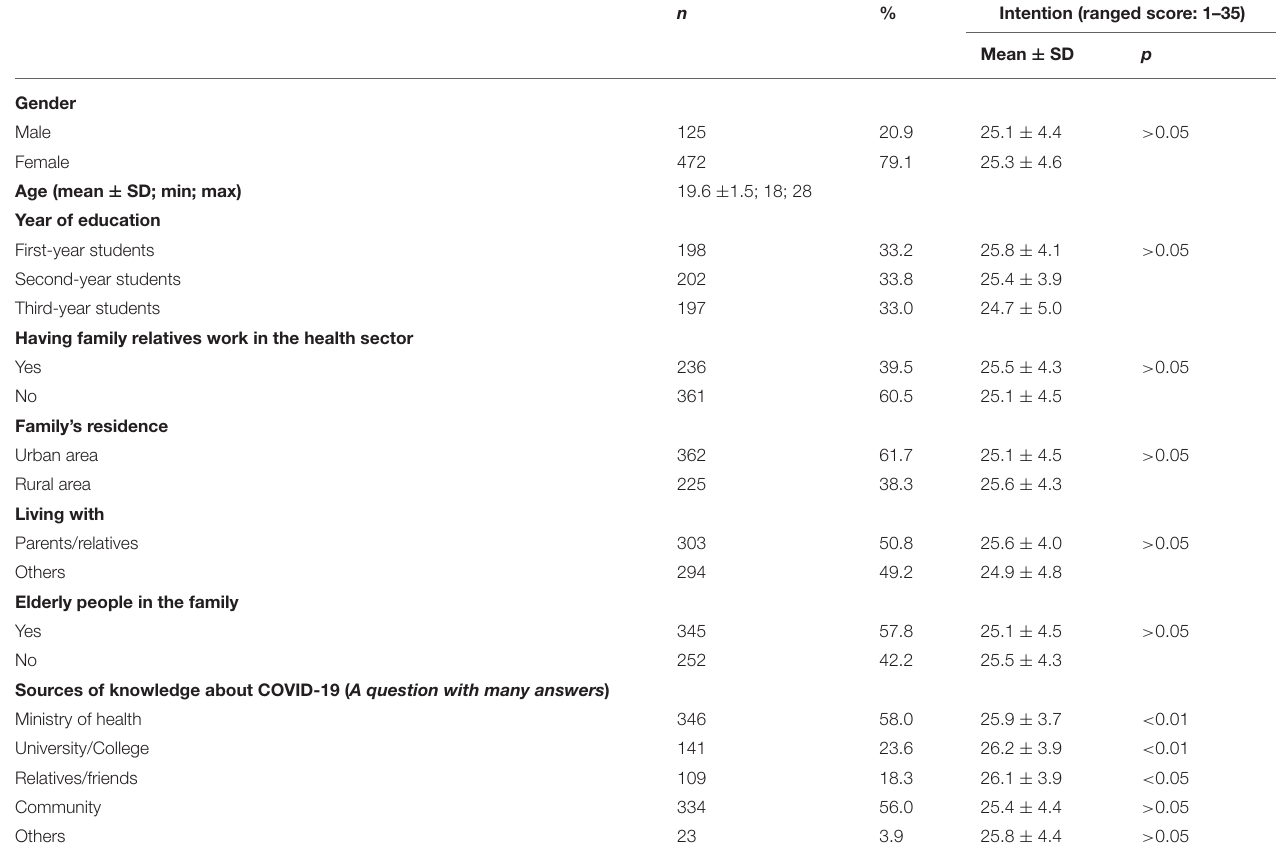
TABLE 1 | General characteristics of the participants and the intention score (n = 597).